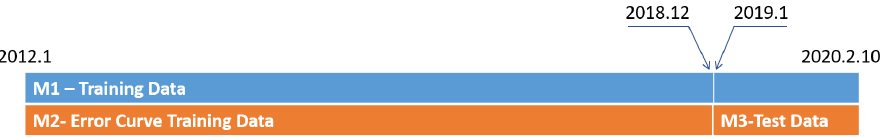
Figure 2. Data split for each model.